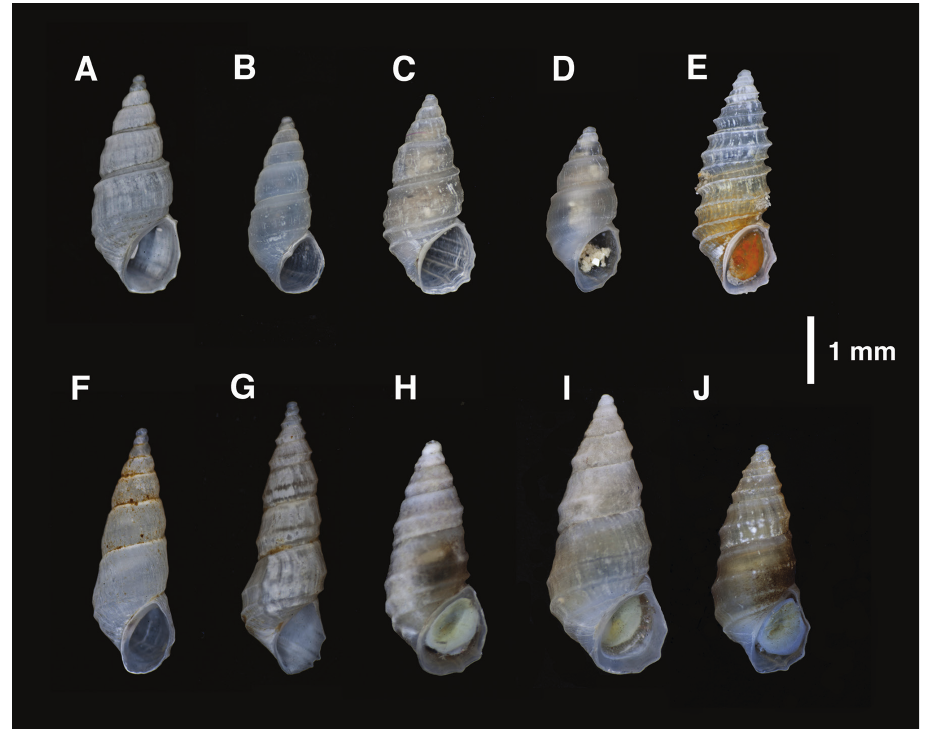
Figure 2. Specimens of: Dianella schlickumi from Lake Amvrakia ( A–E ) and Dianella thiesseana from Lake Trichonis ( F–J ) , demonstrating their large inter-specific variation of shell